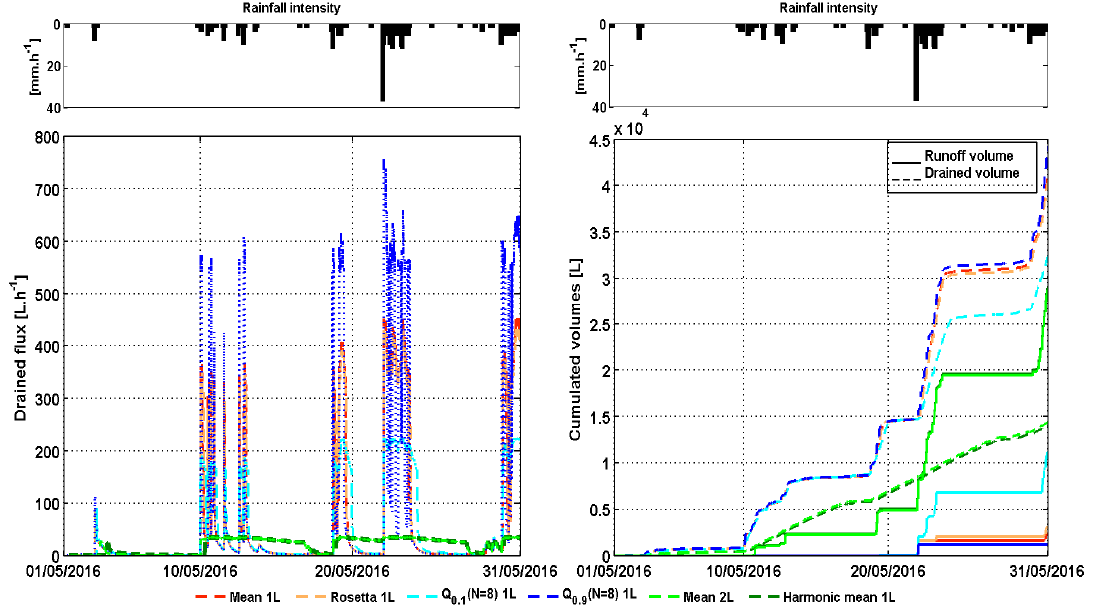
Figure 6. Simulation results: drained flux (L·h − 1 ) and cumulated drained/runoff volumes (L) over one month period.